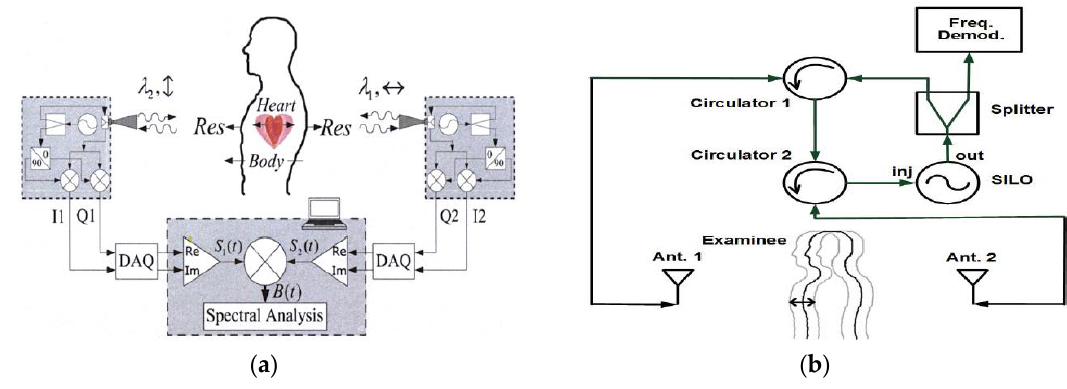
Figure 19. ( a ) Random body movement (RBM) cancellation using two identical transceivers [111]; ( b ) self-injection radar for RBM cancellation [128].